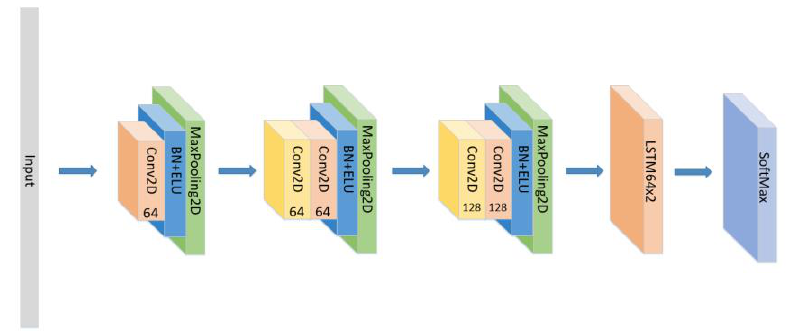
Figure 6. The construction of the CNN+LSTM×2 model.